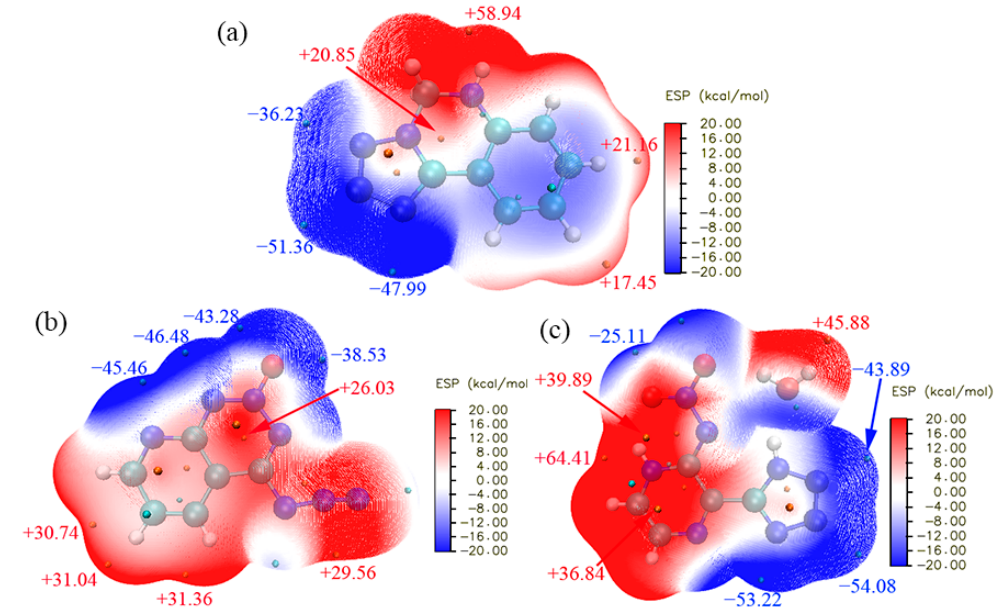
Figure 11. Electrostatic potential surfaces of Crystal a ( a ), Crystal b ( b ) and Crystal c ( c ).